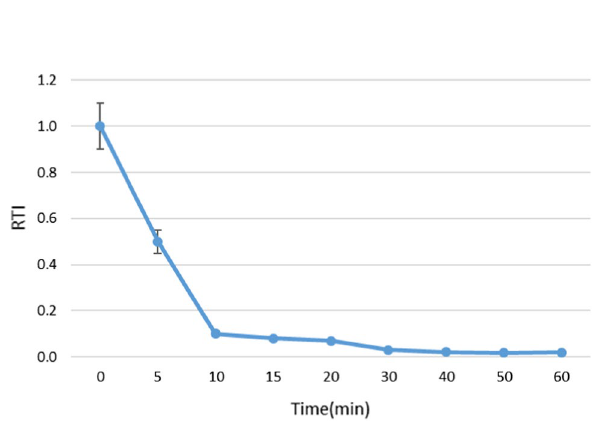
Fig. 5 Toxicity reduction curve during EC